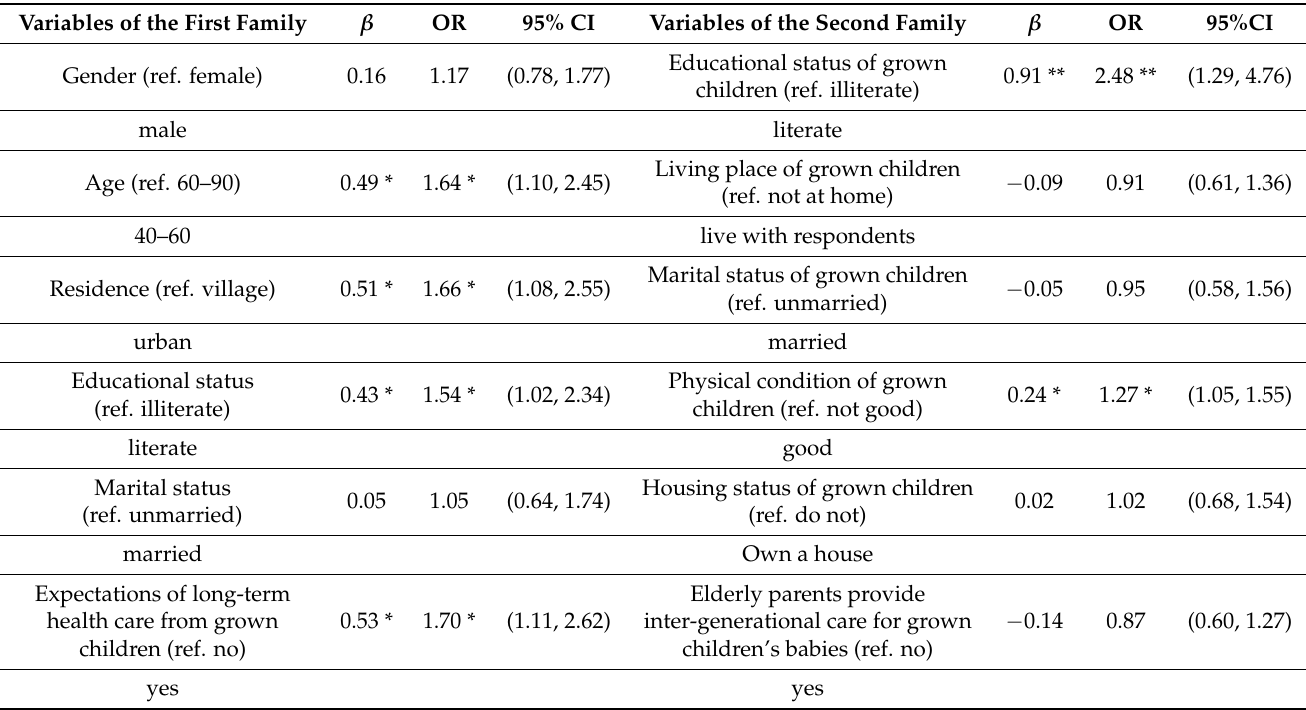
Table 3. Grouping logistic regression of the indicators to